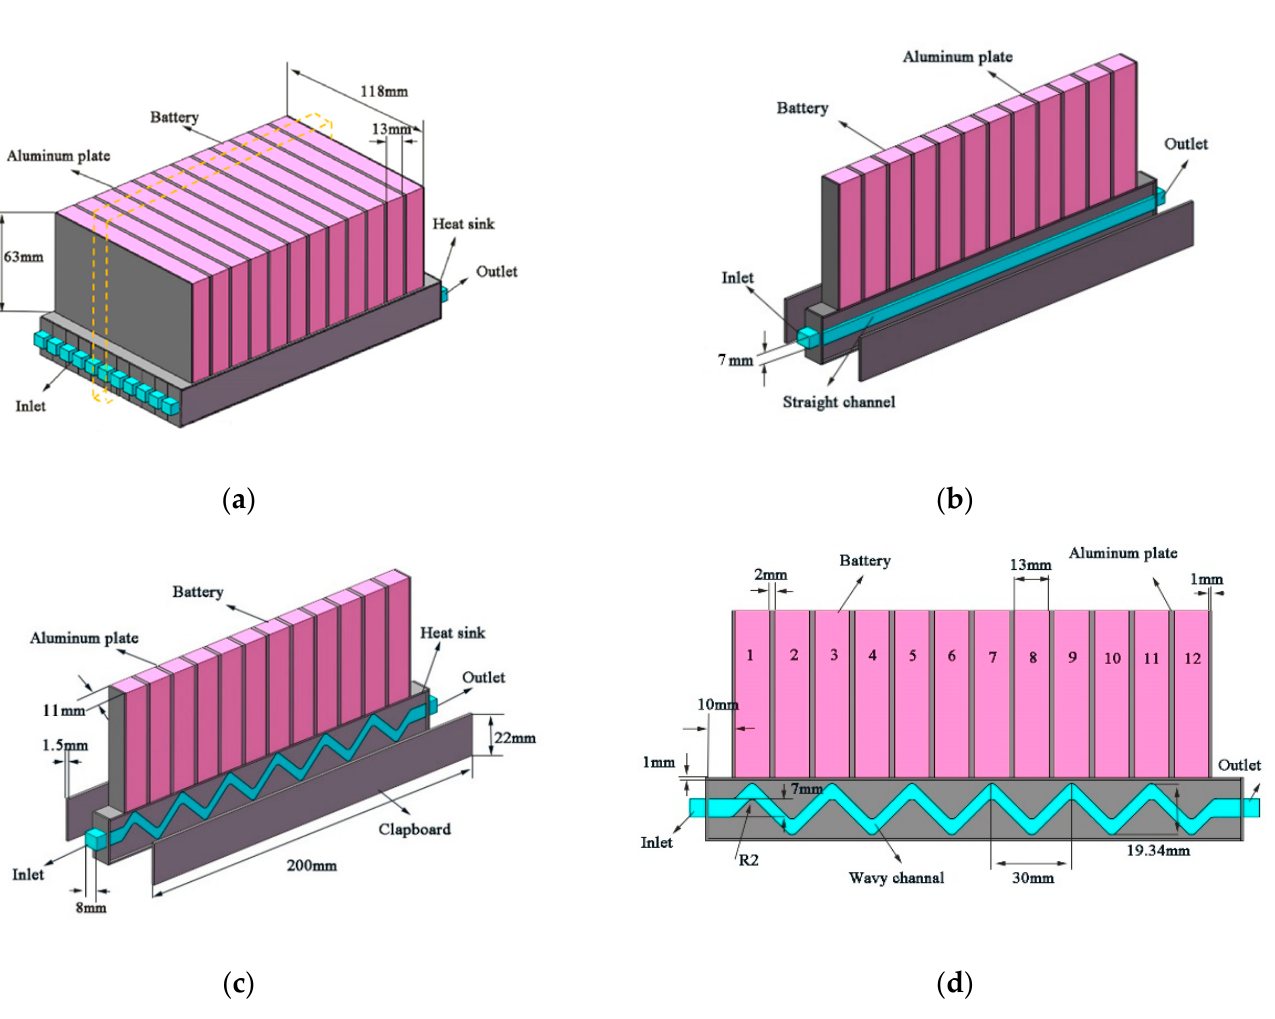
Figure 2. Liquid-cooled BTMS: ( a ) overall view; ( b ) straight channel; ( c ) wavy channel; ( d ) detailed dimensions of wavy channel. Table 1. Model parameters [33,34].